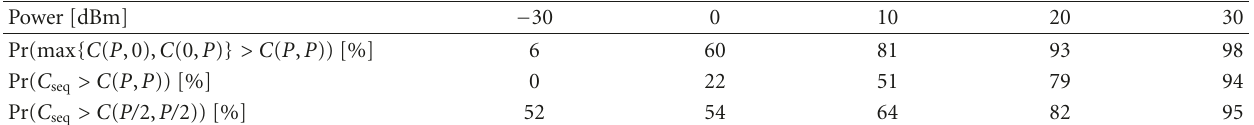
Table 1: Single and Sequential Transmissions versus Simultaneous Transmission. Disk Radius R = 100 m. Power [dBm]